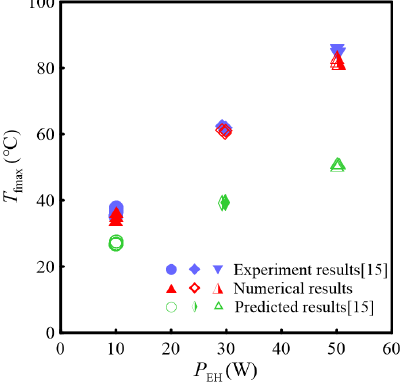
Fig. 5. Reliability verification of the numerical